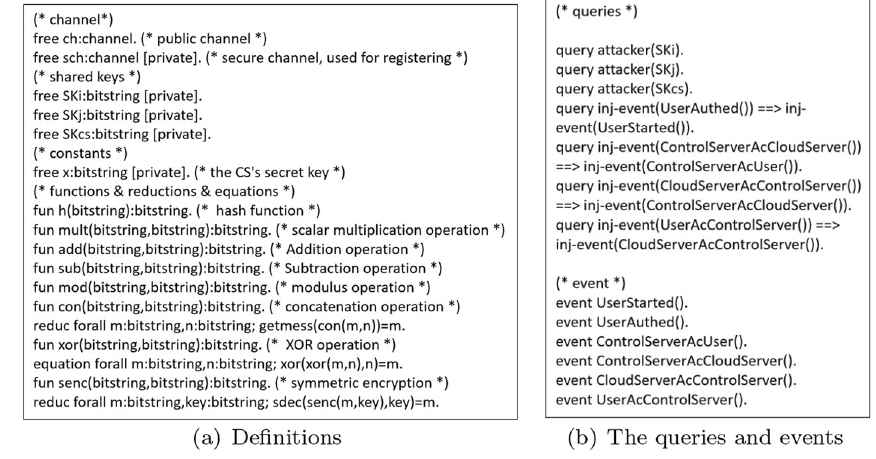
Fig. 4 Definitions, queries, and events